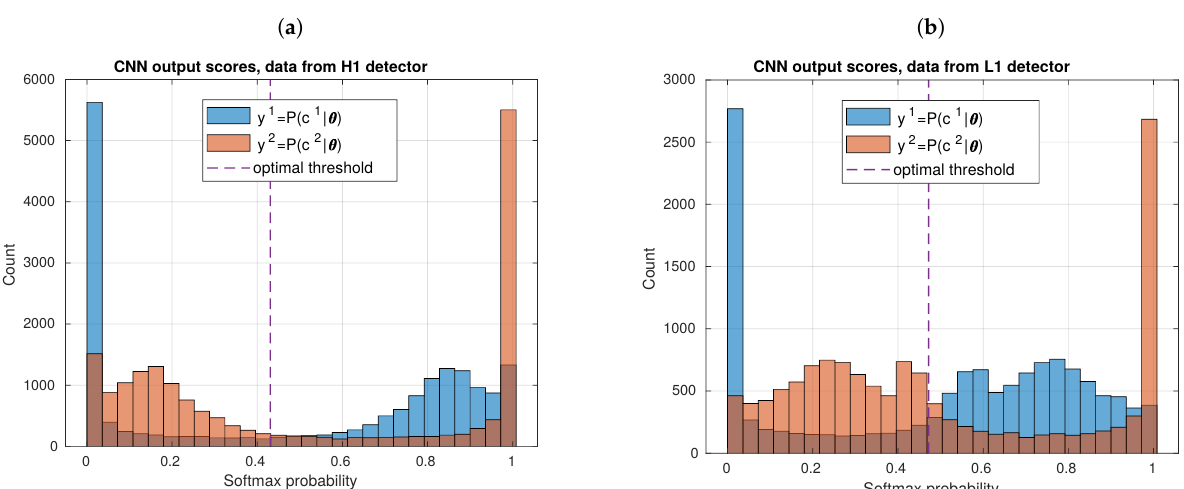
Figure 13. Histogram of CNN output probabilistic scores, y 1 and y 2 , working with data from H1 detector ( a ) and from L1 detector ( b ). As it can be observed from the skewness towards edge bins, the CNNs are more optimistic predicting GW samples than predicting noise alone samples. Besides, with H1 data, there is less uncertainty than with L1 data, because, with L1 data, there is more population of occurrences in middle bins. Here, we counted all 100 N test